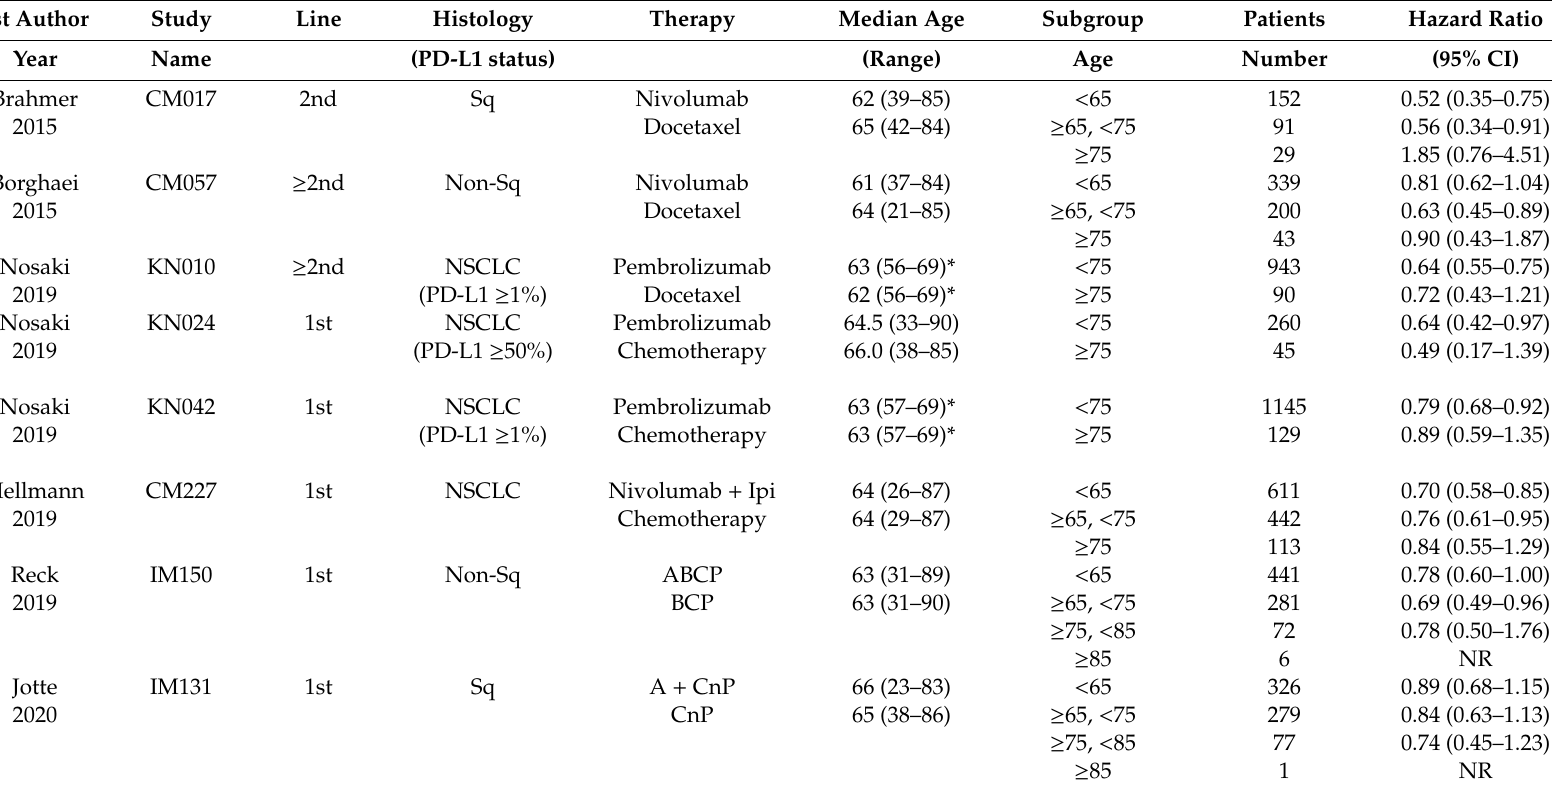
Table 1. Hazard ratio for overall survival in < 75 vs. ≥ 75 year-old patients with advanced non-small cell lung cancer in phase III